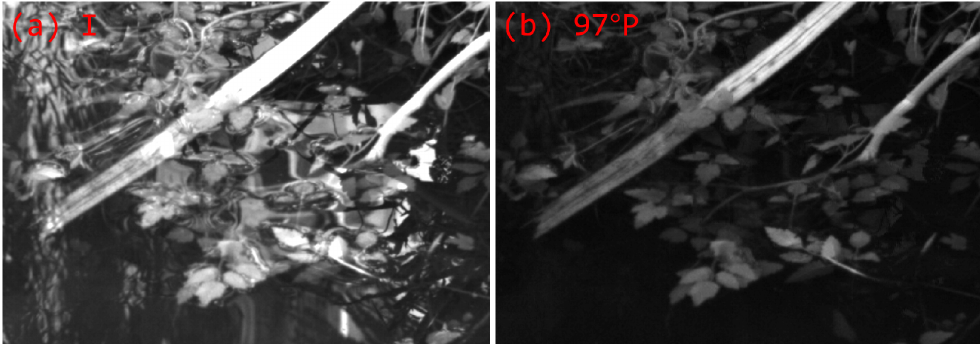
Figure 8. Comparison between optical intensity image and optical polarization image in case Ⅱ